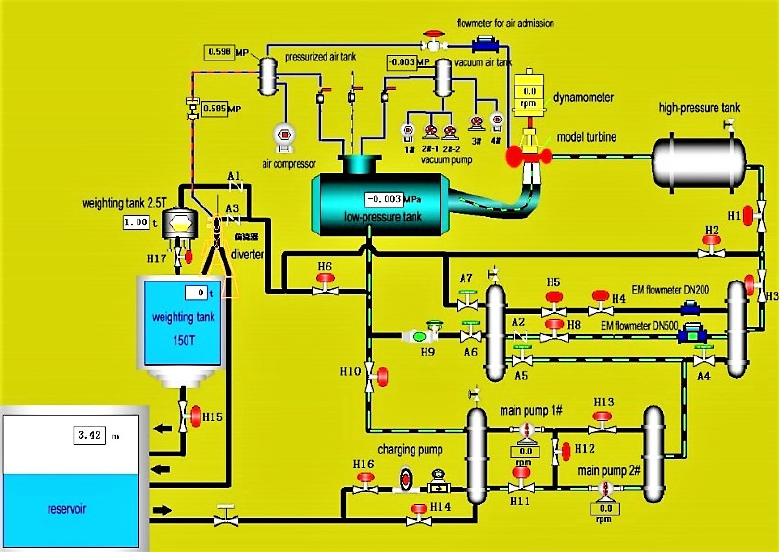
Figure 14. Layout of the Universal Test Rig for Hydraulic Machinery (UTR-HM).